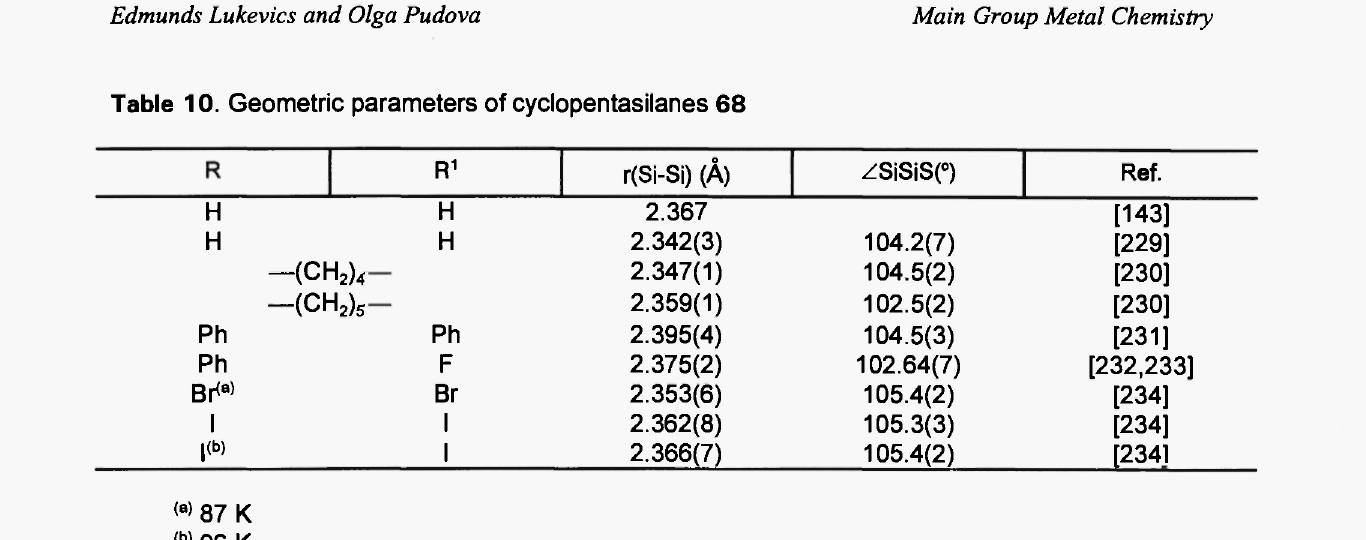
Table 10. Geometric parameters of cyclopentasilanes